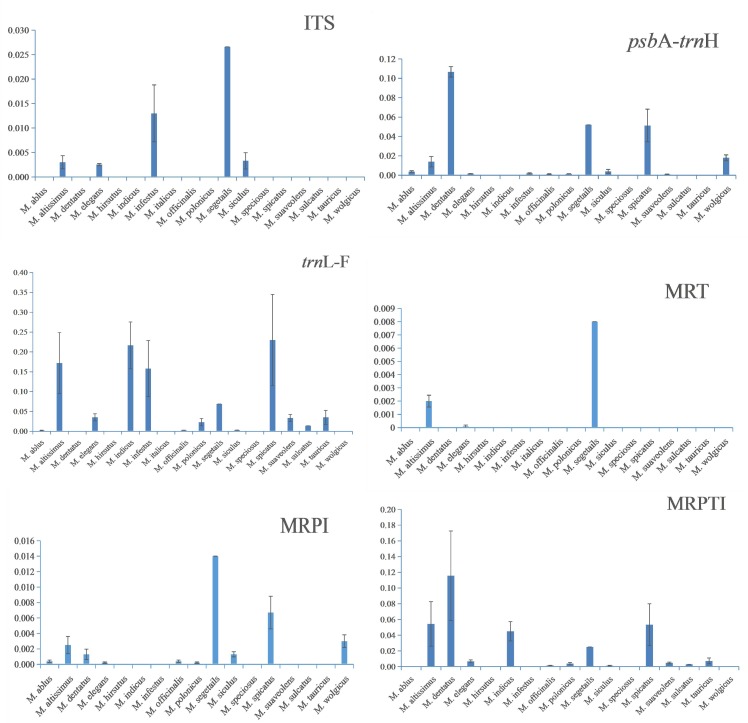
Average intraspecific gene gap value for single and combined regions based on the analysis of hundreds of sequences by pairwise sequence alignment.ITS, internal transcribed spacer.